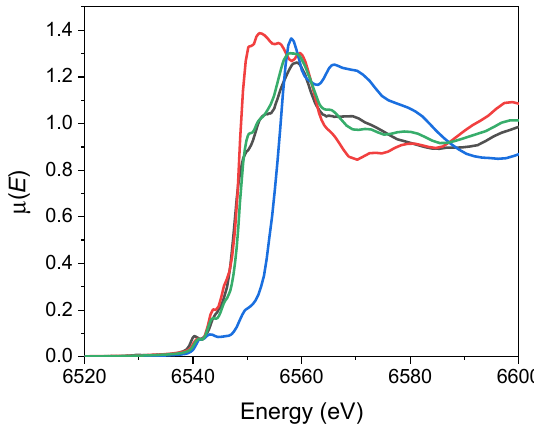
Figure 2. Mn K -edge X-ray absorption near-edge structure (XANES) for K 0.985 Mn 0.015 TaO 3 ± δ (black), MnTiO 3 (red), SrMnO 3 (blue). A fit of the K 0.985 Mn 0.015 TaO 3 ± δ XANES using a linear combination of the spectra for MnTiO 3 and SrMnO 3 is shown in green.